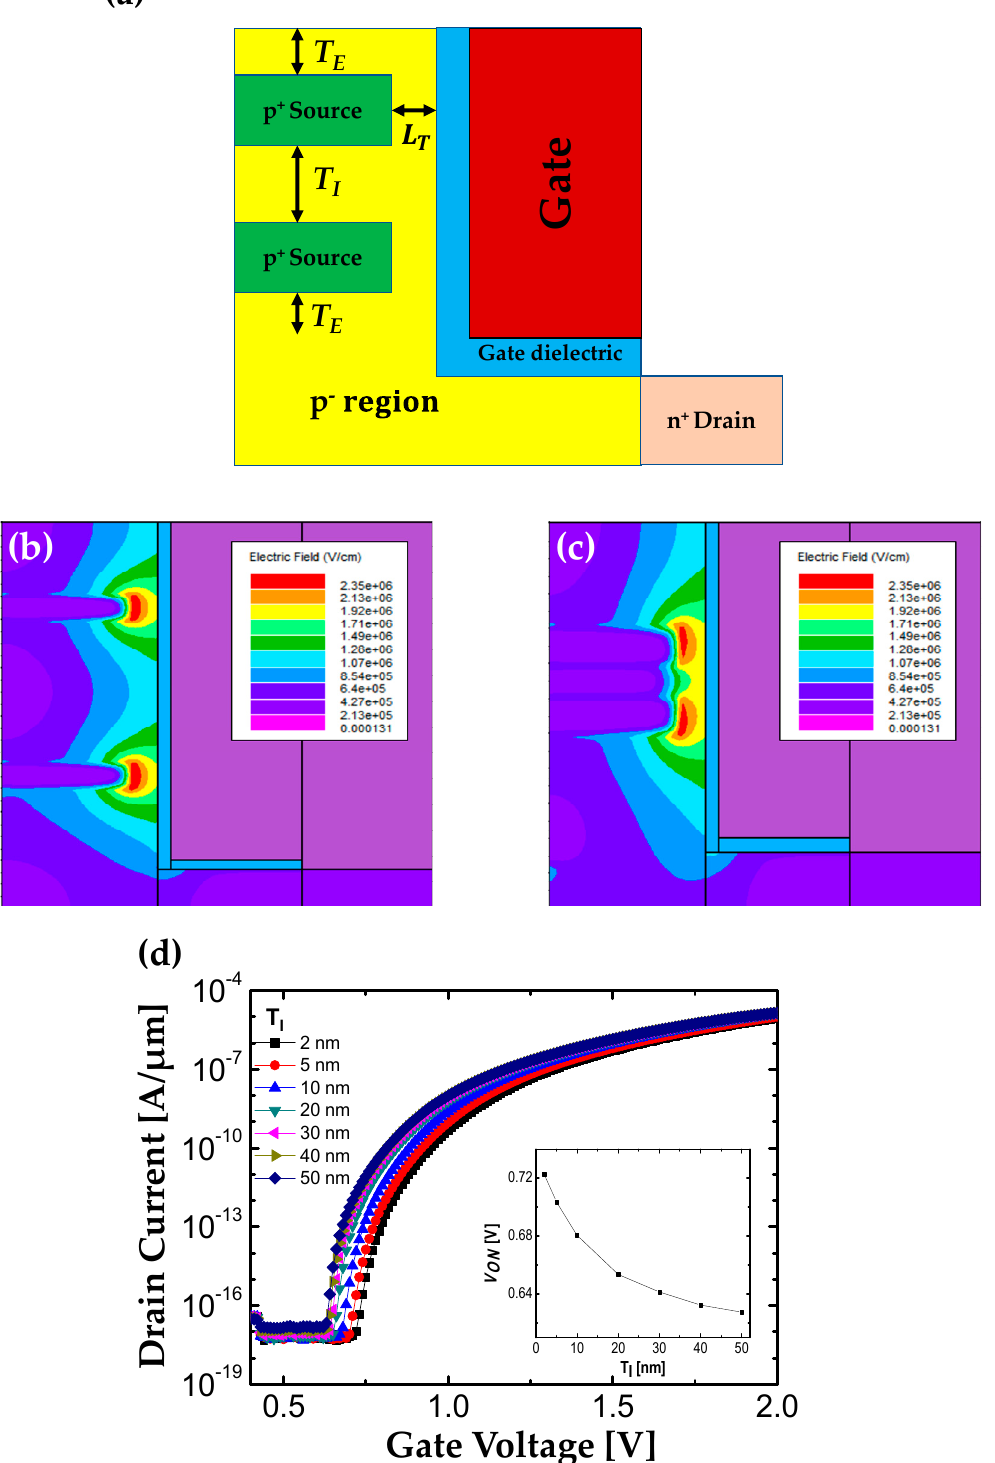
Figure 5. ( a ) Structure of F-shaped TFET with multiple sources. Electric field contour plots for ( b ) T I = 30 nm and for ( c ) T I = 5 nm at V DS = 0.7 V, V GS = 0.86 V. ( d ) Transfer characteristic as T I increases from 2 to 50 nm at V DS = 0.7 V. The inset figure shows extracted V ON .